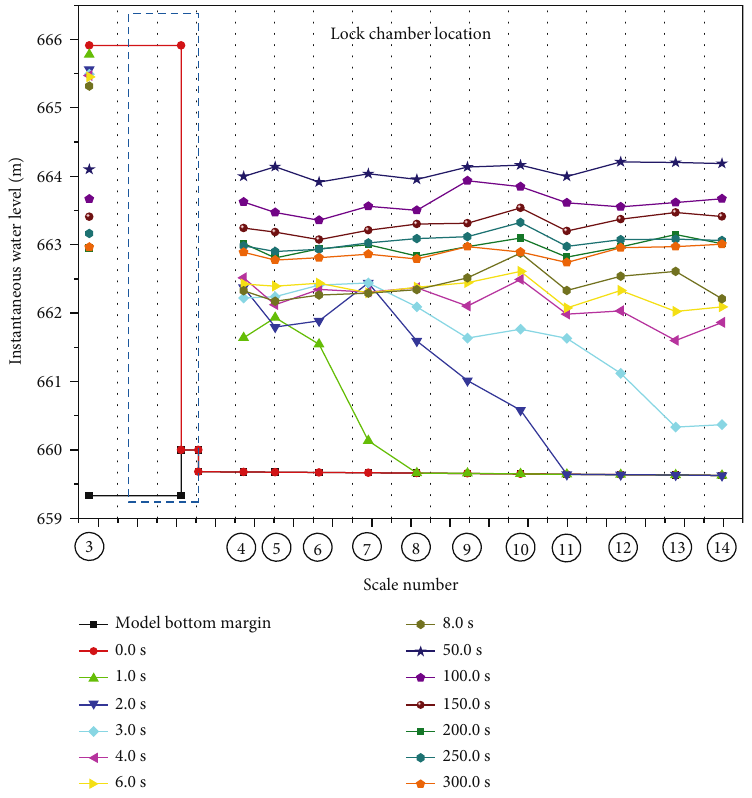
Figure 9: Instantaneous water surface pro fi les at di ff erent times under operating condition